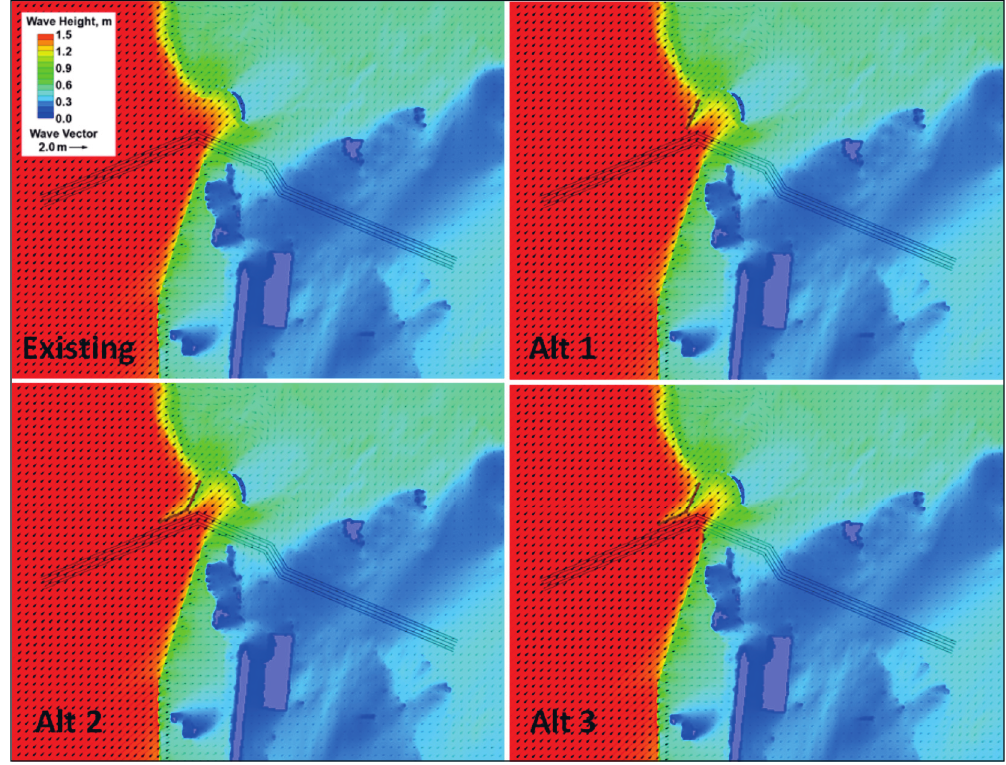
Figure 16. Example of model calculated wave heights in the west channel for the 50-year design winds from SW at 1.5 m water level.